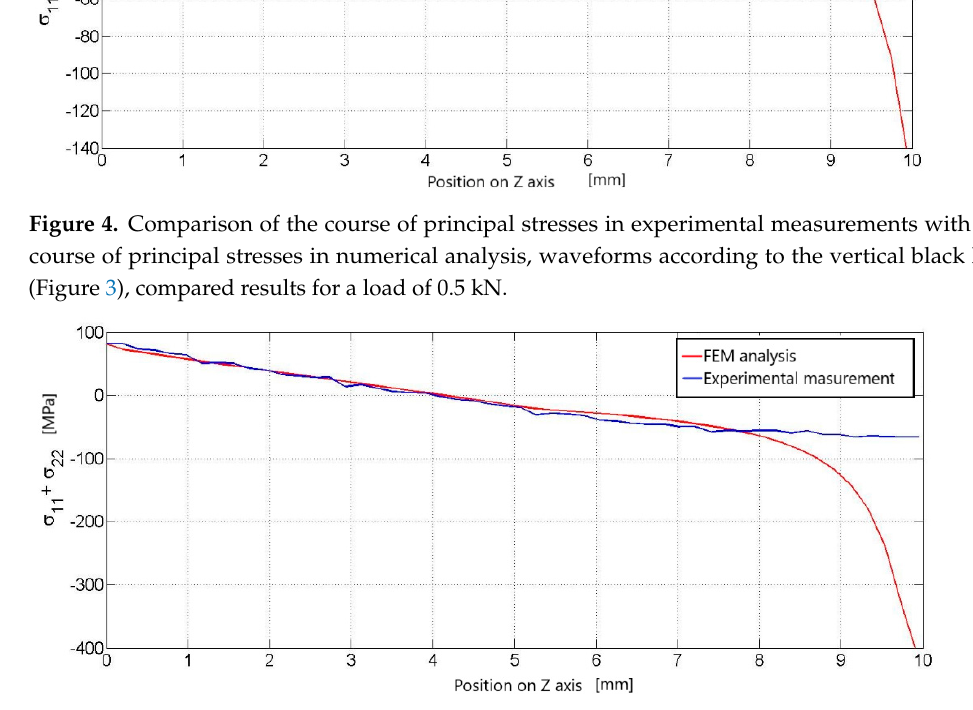
Figure 5. Comparison of the course of principal stresses in experimental measurements with the course of principal stresses in numerical analysis, courses along the black line (Figure 3), compared results for a load of 2 kN.